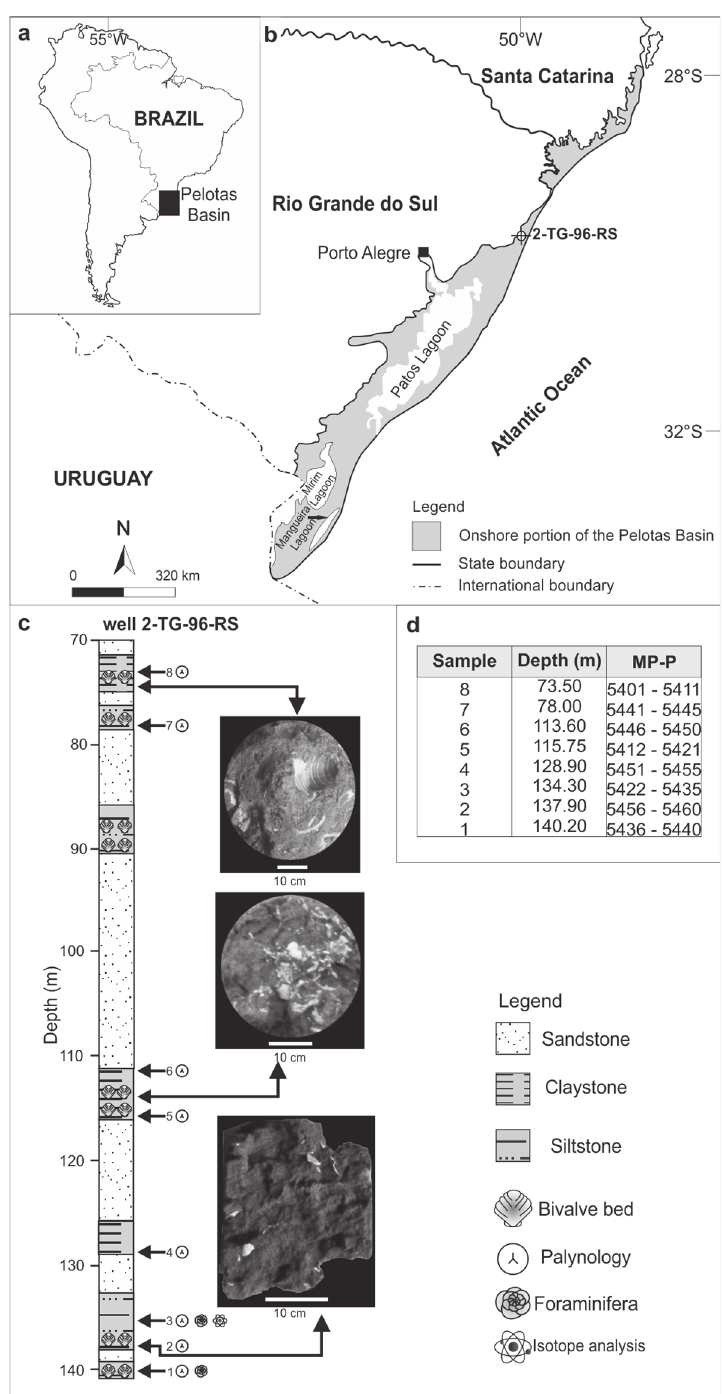
Fig. 1 - Area location and sampling of the well 2-TG-96-RS in Pelotas Basin (a-b) . Stratigraphic column of the interval studied, showing the position of micropaleontological and 87 Sr/ 86 Sr isotopes samples analyzed in the present study (c) and list of palynological samples (d) (MP-P refers to the slide collection of the